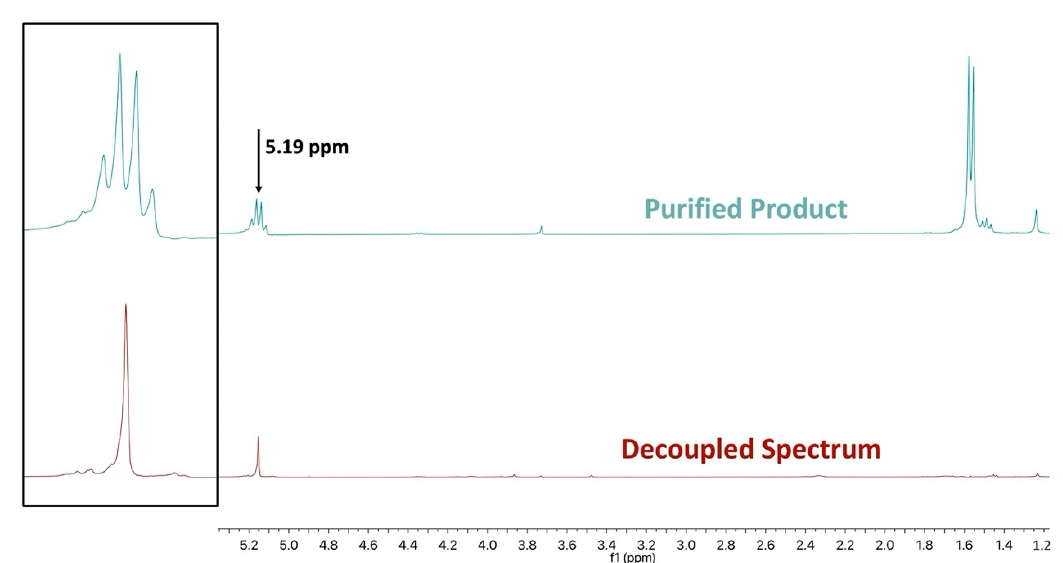
Figure 7. 1 H NMR spectrum of the purified product (comparison between standard 1 H NMR and decoupled 1 H NMR). The expansion of the region of interest is reported in the black box.